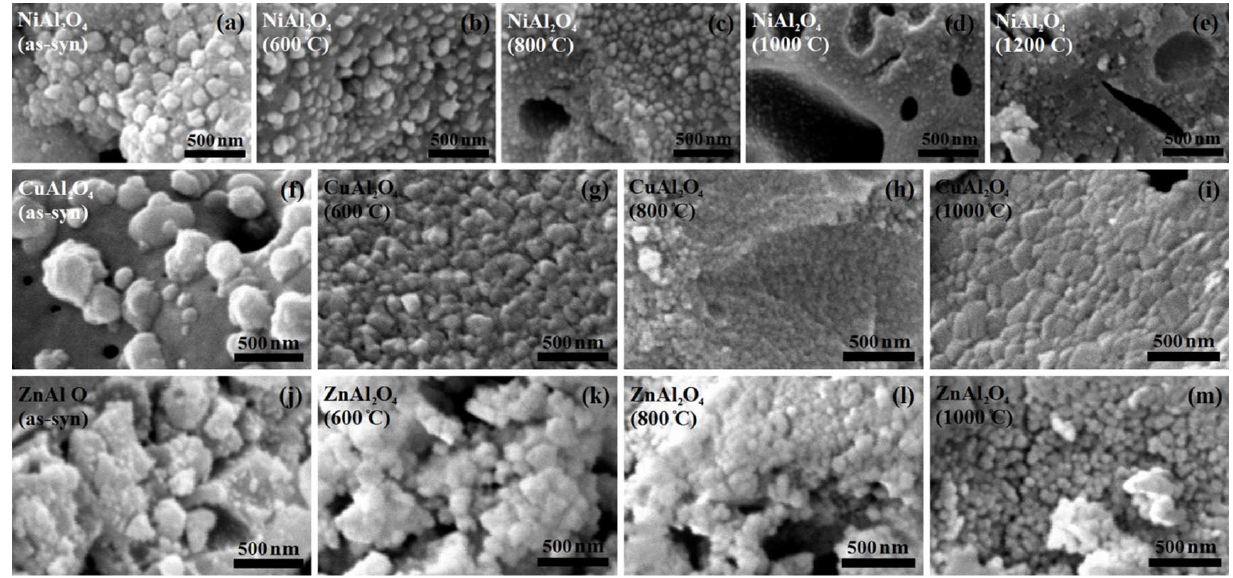
Fig. 3 SEM images of NiAl 2 O 4 , CuAl 2 O 4 , and ZnAl 2 O 4 powders calcined at different temperatures.